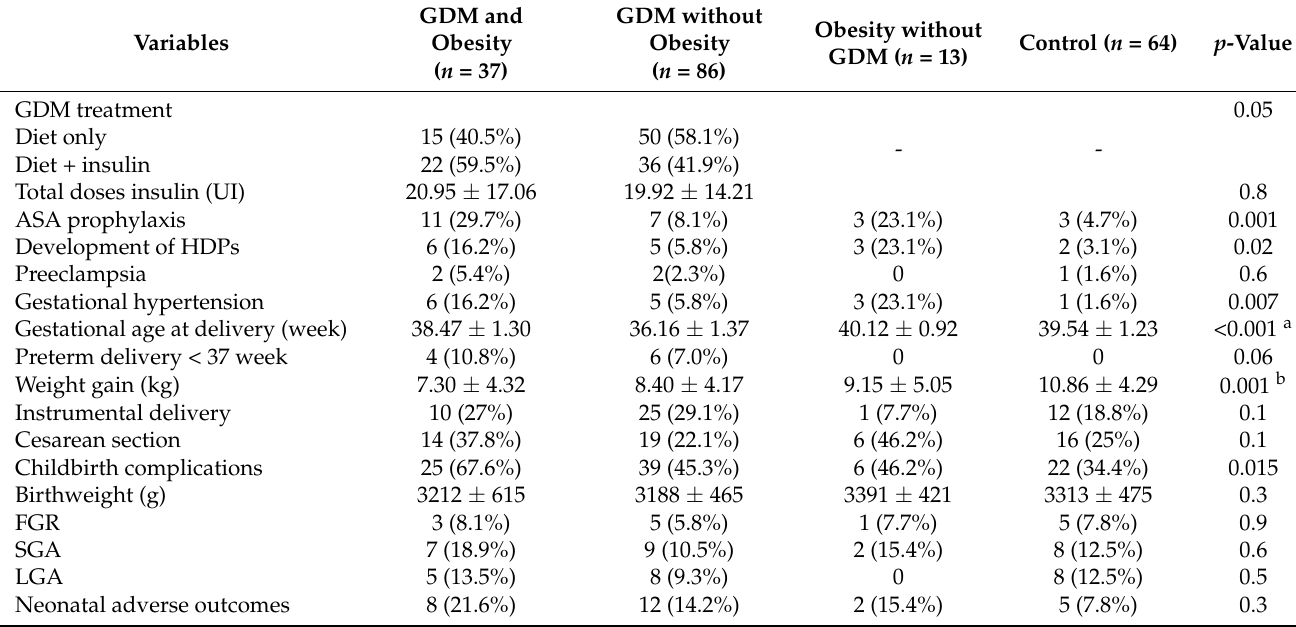
Table 2. Characteristics of pregnancy and obstetric and perinatal outcomes according to the presence of GDM and/or